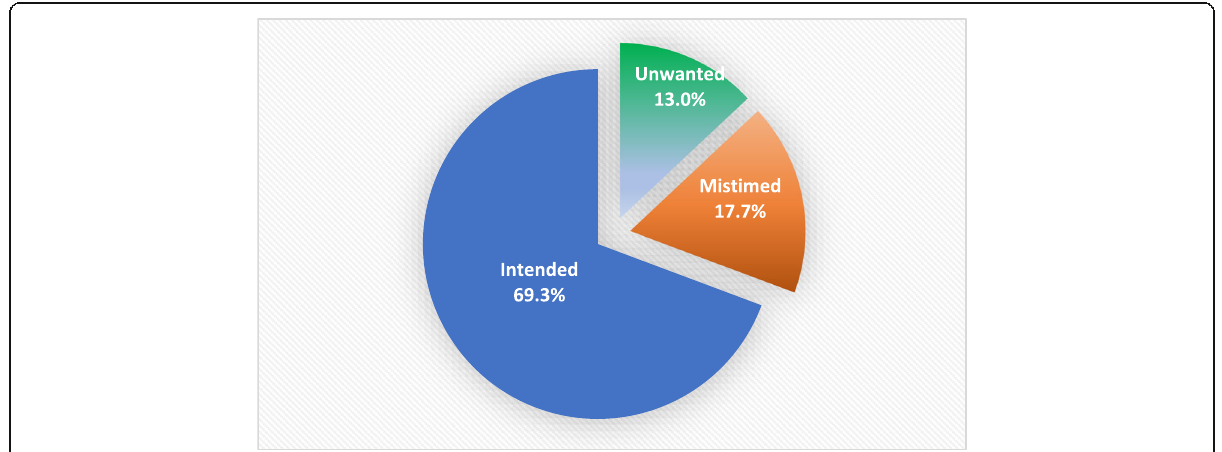
Fig. 1 Pregnancy intention status among women in Sohag district,